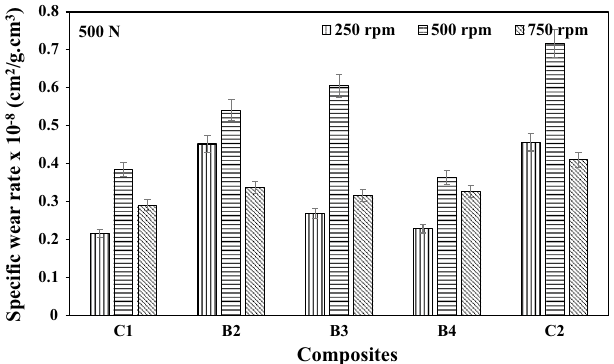
Figure 8. Specific wear rate of composites at load 500 N load under different speed.